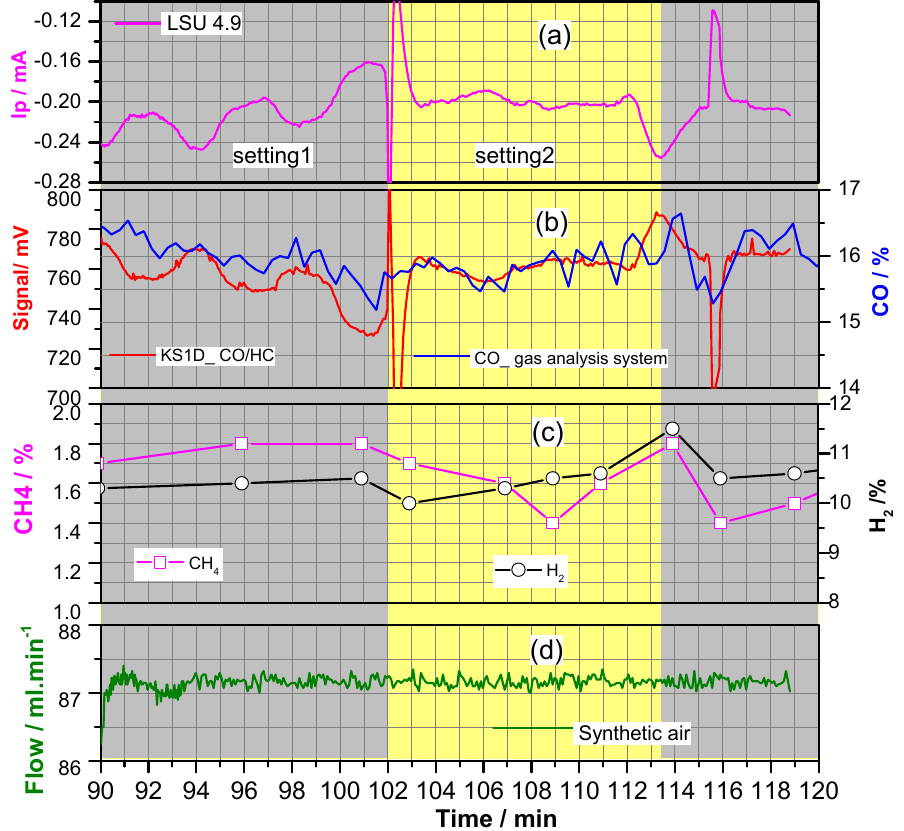
Figure 8. Composition and sensor signals vs. one time period (setting 1/setting 2) for tar estimation. ( a ) Residual oxygen concentration represented by Ip (LSU 4.9). ( b ) CO concentration and KS1D- signal. ( c ) Concentrations of CH 4 and H 2 measured by the gas analysis system. ( d ) Synthetic air flow adjusted to fulfil the λ = 1 condition at minute 94 and a controlled constant over the time beyond.